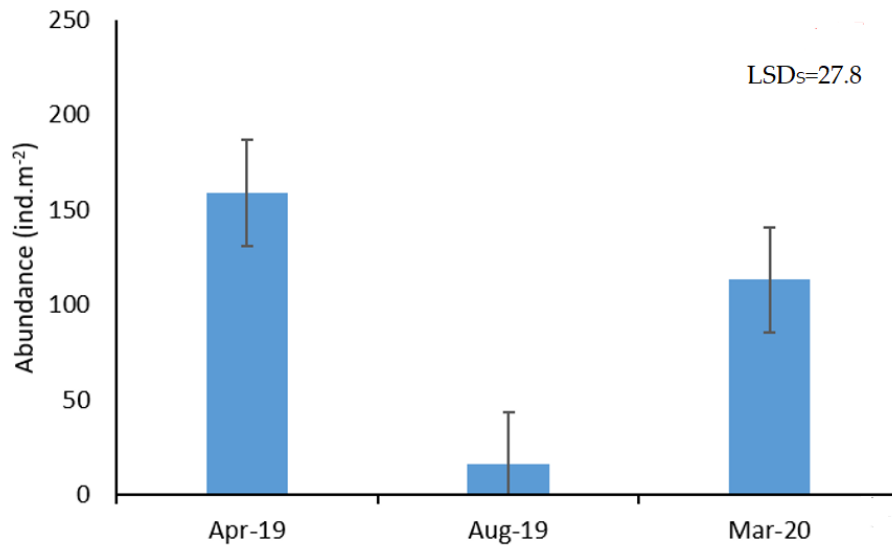
Figure 3. The variation in abundance of soil macrofauna across the three sampling times recorded after 17 years of trial establishment. S = sampling time.